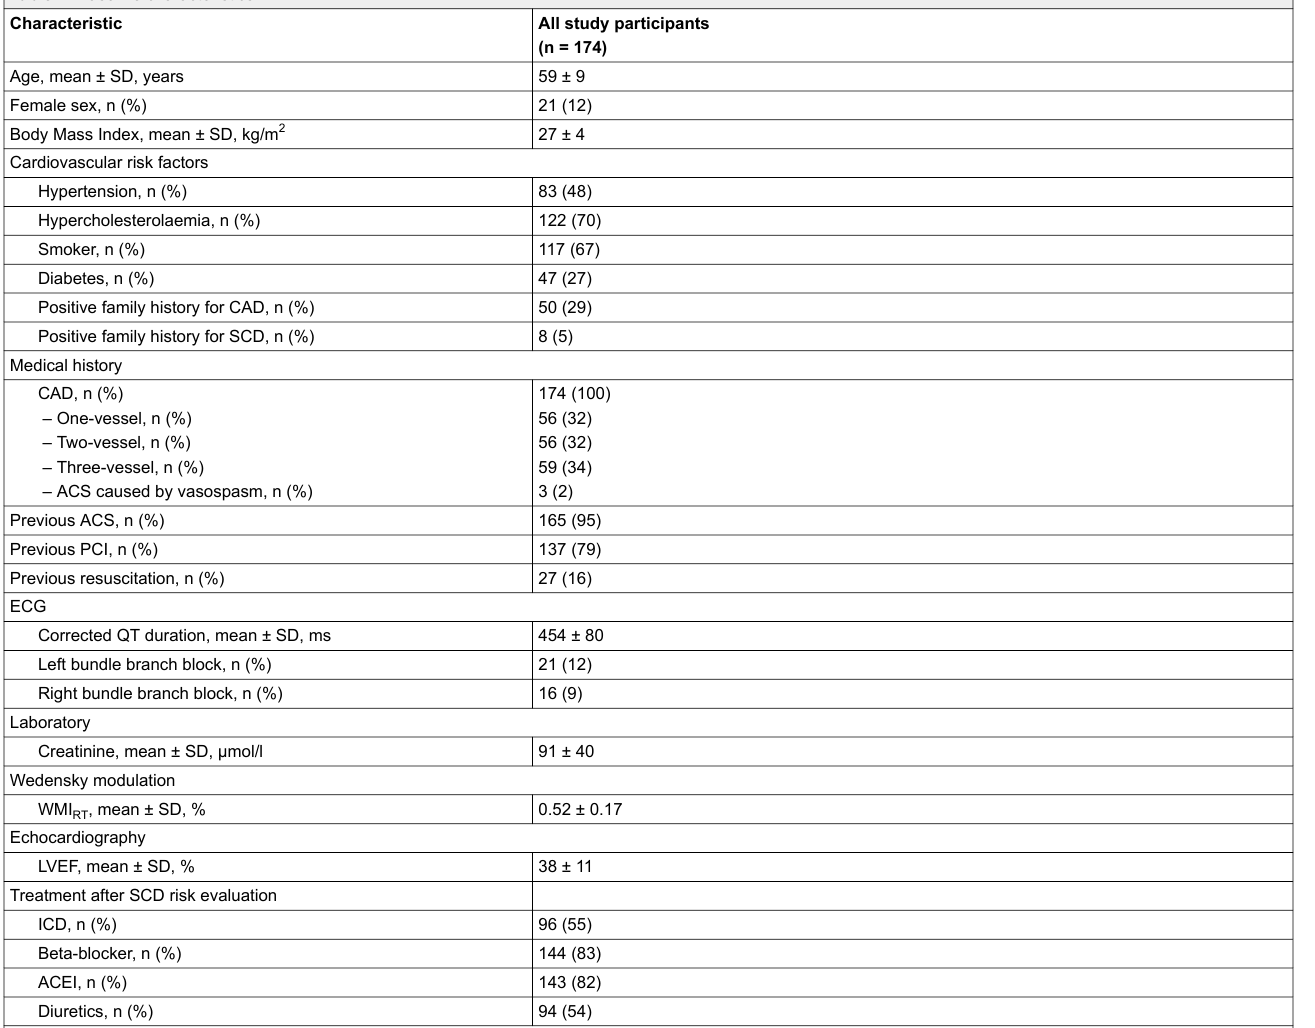
Table 1: Baseline characteristics.